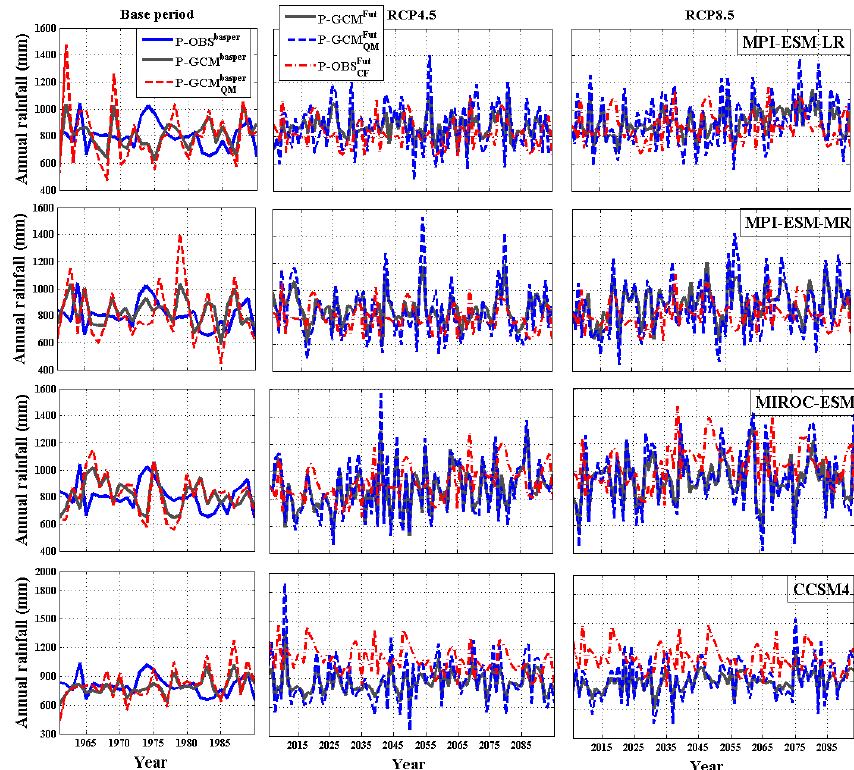
Figure 10. As in Fig. 7 but for the